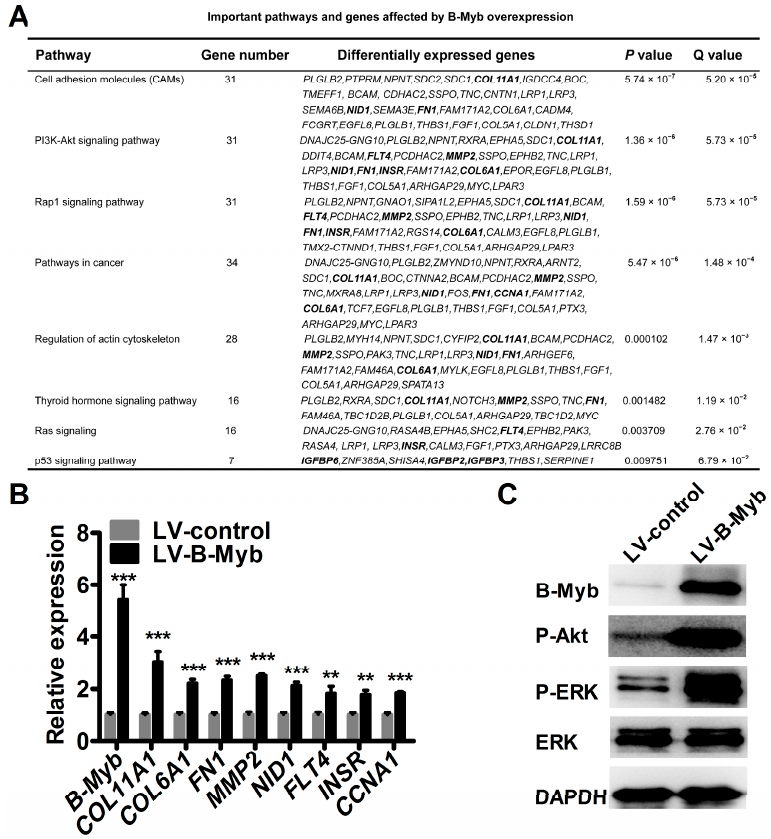
(Table S1). Pathway analysis on the dysregulated genes affected by B-Myb overexpression identified signaling pathways including cell adhesion molecules, phosphatidyl inositol-3 kinase (PI3K)-Akt signaling pathway, pathways in cancer, and Ras signaling pathway (Figure 7A). The genes in these pathways include, among others, COL11A1 , COL6A1 , FN1 , MMP2 , NID1 , FLT4 , INSR , and CCNA1 , which are known to be involved in proliferation, tumorigenesis, and metastasis. Quantitative RT-PCR analysis further confirmed that these genes were indeed up-regulated in stable LV-B-Myb overexpression cells compared with LV-control cells (Figure 7A). Notably, the qRT-PCR results corresponded well to the RNA-seq data (Figure 7B). Moreover, an immunoblot analysis demonstrated that overexpression of B-Myb significantly increased the levels of phosphorylated ERK and Akt. Taken together, these findings strongly suggest that B-Myb might promote lung cancer development at least partially though positive regulation of ERK and Akt signaling pathways.